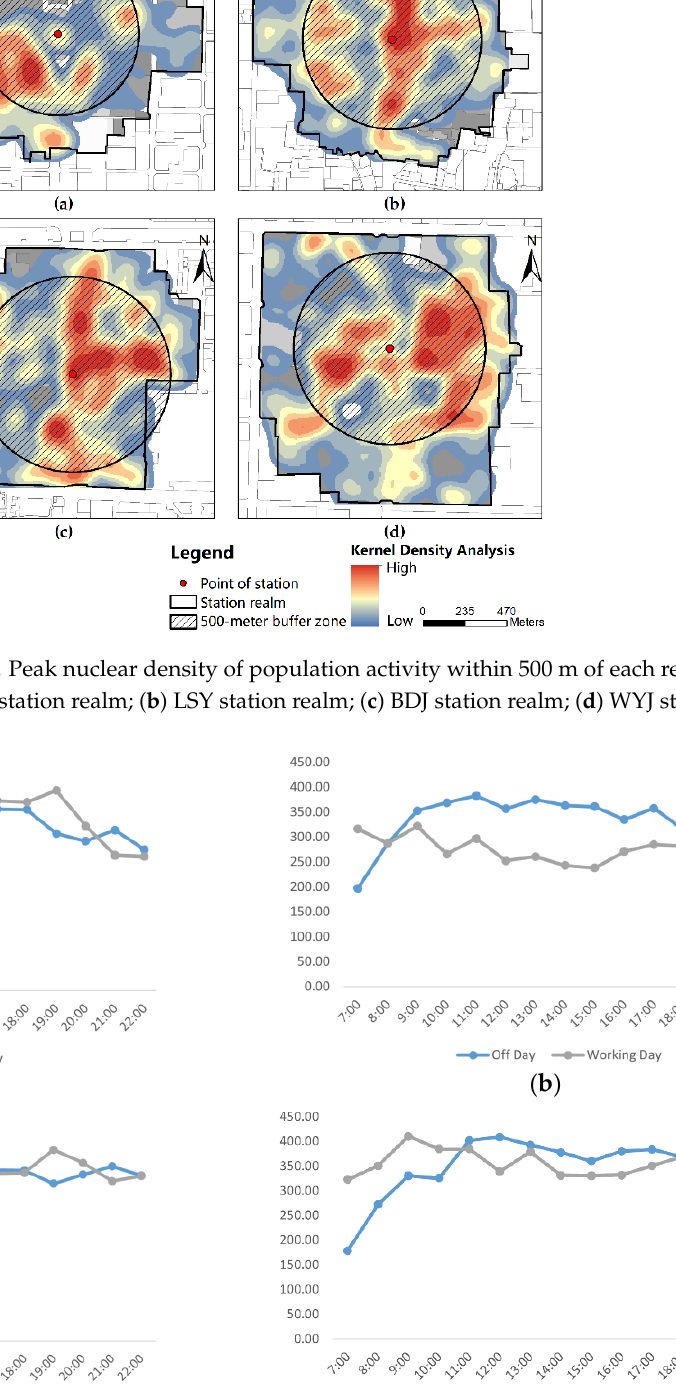
Figure 12. The peak kernel density of population activities in the study station realm during working days and off days: ( a ) XZZX Station, ( b ) LSY Station, ( c ) BDJ Station, ( d ) WYJ Station.